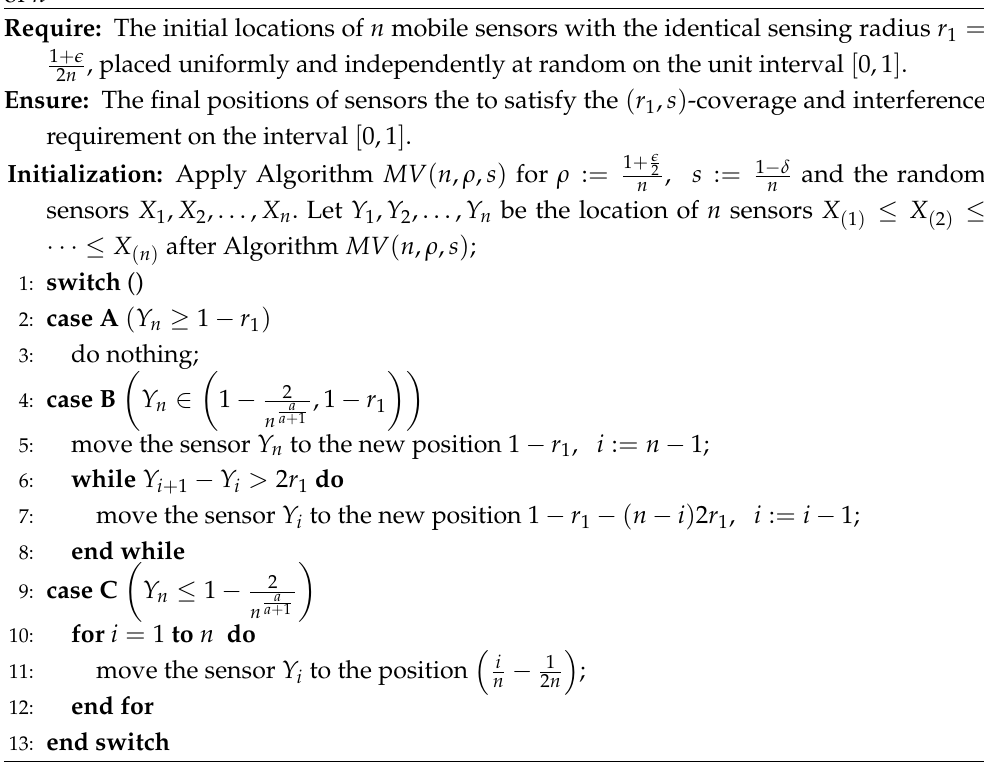
Algorithm 3 CV 2 ( n , r 2 , s ) for the ( r 2 , s ) -coverage and interference requirement on the [ 0, 1 ]